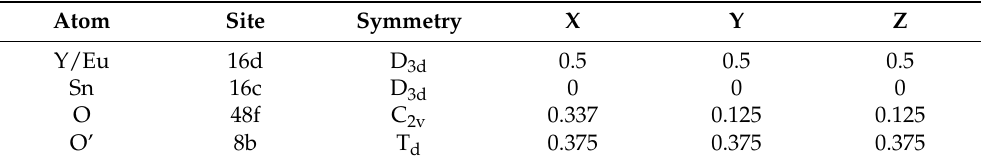
Table 1. Atomic coordinates and site occupancy fraction for Y 2 Sn 2 O 7 :9%Eu.